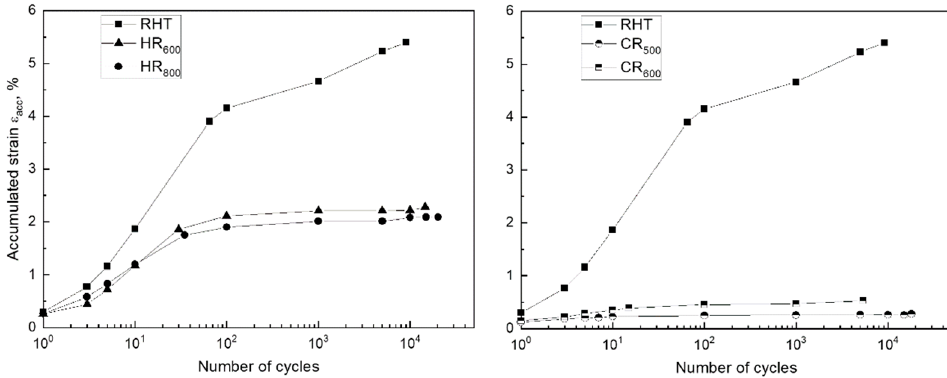
Figure 6. Evolution of the accumulated strain with an increase in the number of cycles for the Fe-30Mn-5Si alloy after various treatment regimes. The error limits do not exceed the size of symbols.